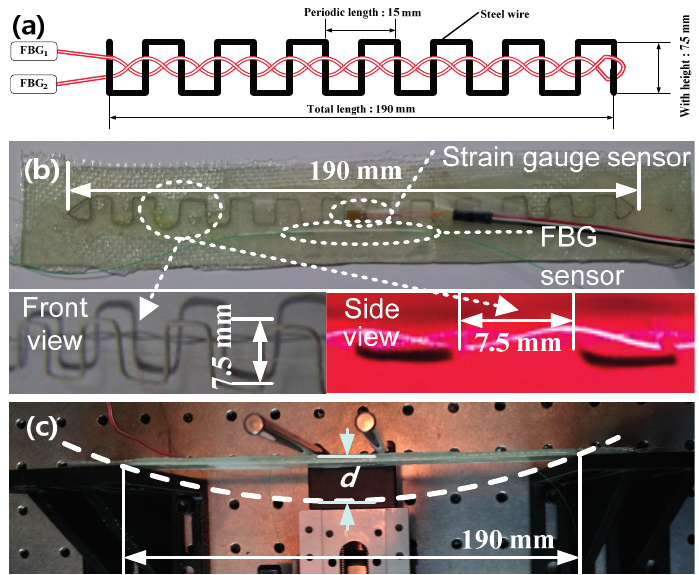
Figure 7. A schematic and experimental setup for the measurement of FRP coupon strain. ( a ) Schematic of the proposed intensity-based FOS head; ( b ) three types of strain sensors bonded on the FRP surface; ( c ) experimental setup to measure FRP